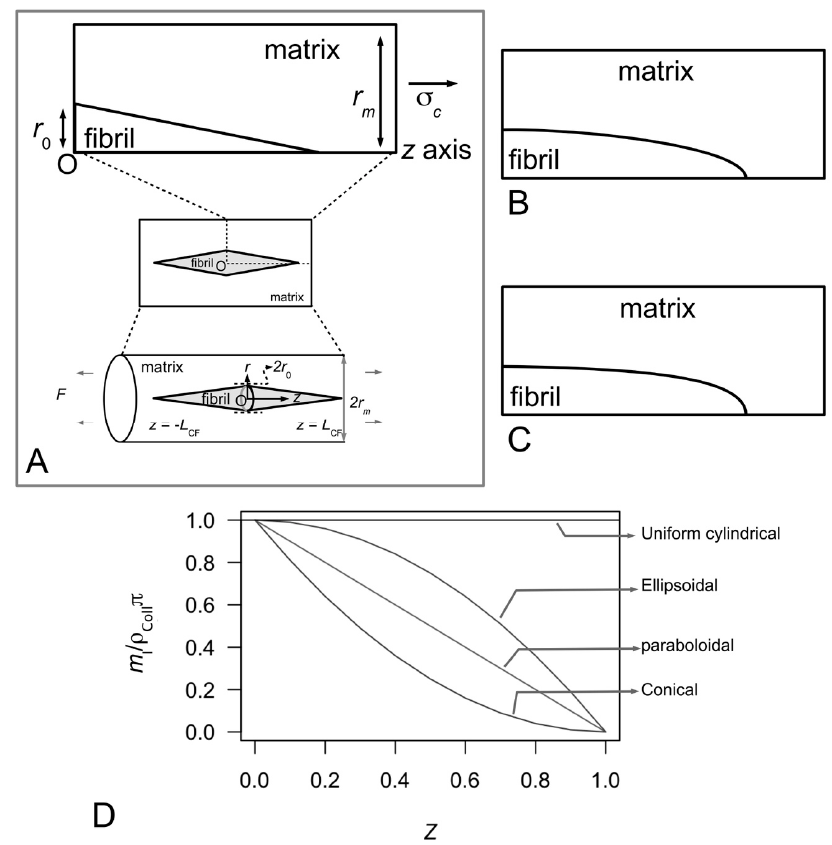
Figure 10. Tapered fibril reinforcing connective tissue. ( A ) A fibril with conical ends, concentrically arranged within the ECM. In this general model (see illustrations at the bottom and middle panels), the fibril possesses mirror symmetry about the fibril centre, O, and axis symmetry, which defines the z -axis of the cylindrical polar coordinate system, so that one-quadrant of the complete model (see illustration at the top panel) need only to be illustrated. The fibril has a radius, r 0 , and a half-length, L CF ; r m represents the radius of the model. The stress acting on the model is represented by σ c , acting in the direction of the axis. The other fibril shapes, namely a fibril with paraboloidal ends, and an ellipsoidal fibril are depicted in ( B , C ), respectively. These models also adopt similar assumptions of mirror and axis symmetry developed for the conical shape so that only one-quadrant of the complete model is illustrated in the respective subfigure ( B , C ). ( D ) Graph of normalized fibril axial mass, m l / ρ π , versus Z from the centre to the end of collagen fibril for the respective shapes. The graphs are obtained by evaluating the respective Equations (15)–(18). Here, m l and ρ Coll represent the collagen mass per unit length and density, respectively.